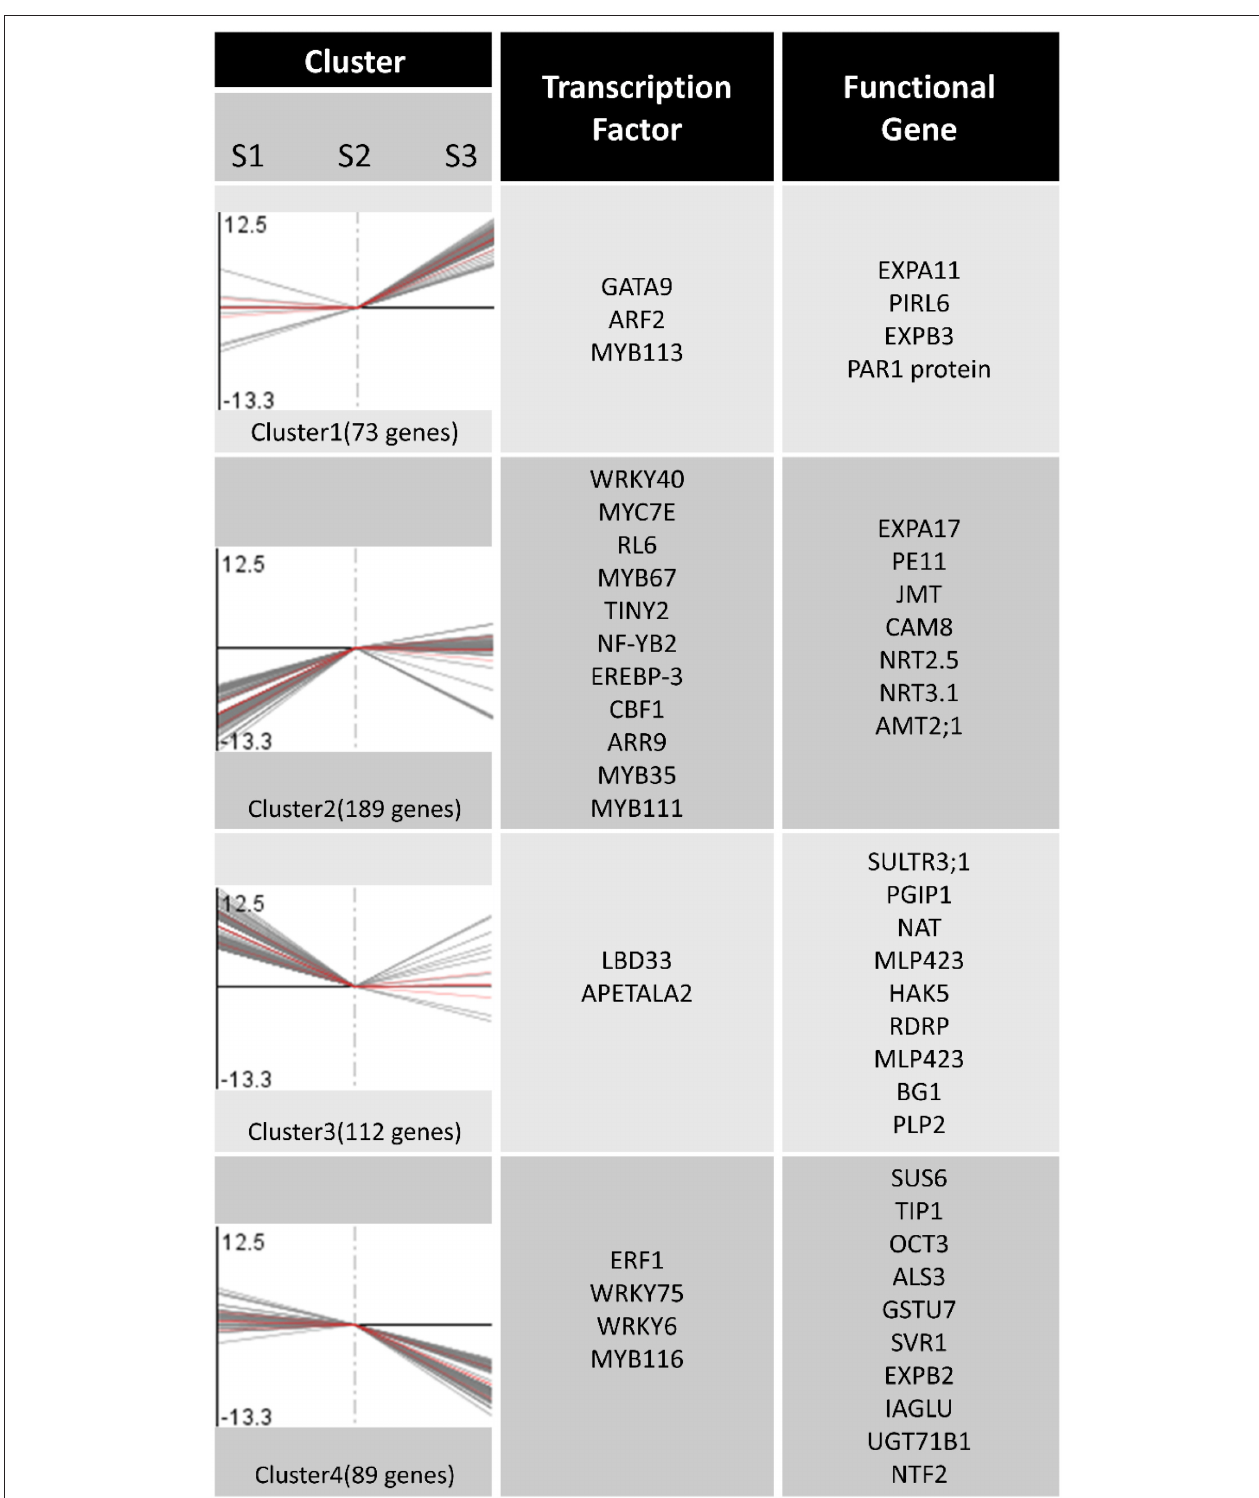
FIGURE 4 | Expression patterns clustering and gene annotation. Two-dimensional hierarchical clustering classifies 463 differential gene expression profiles into four expression cluster groups according to the similarity of their expression profiles.